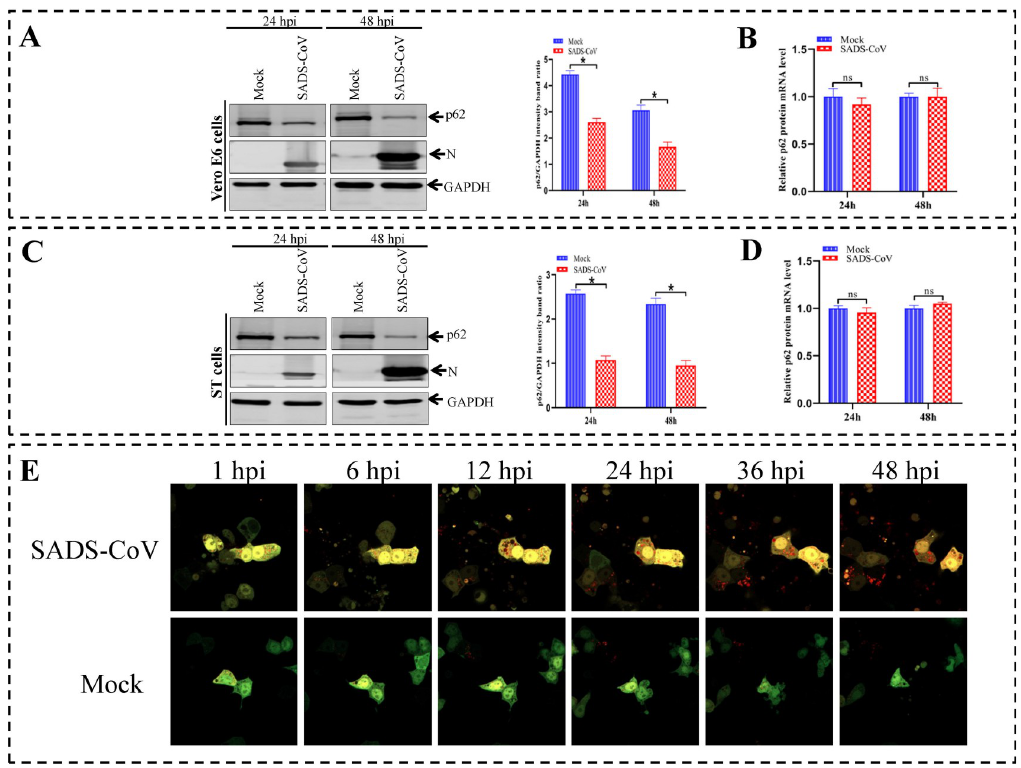
Fig 4. SADS-CoV-induced complete autophagy. ( A and C ) Vero E6 and ST cells are mock-infected or infected with SADS- CoV at the indicated time points (24 and 48 hpi), the cellular lysates are subjected to a western blotting analysis with anti-viral N and anti-p62 antibodies. GAPDH is used as a protein loading control. (B and D) Vero E6 and ST cells are pretreated and infected as described in A and C. Real-time RT-PCR was performed to measure p62 mRNA levels. ( E ) Vero E6 cells are transfected with plasmid GFP-RFP-LC3 for 12 h, and cells were infected or mock-infected with SADS-CoV at an MOI of 1. After absorption for 1 h, cells were observed over time by live cell imaging with RFP and GFP channels. Serial pictures obtained from the video at the indicated time points are shown. Means and SD (error bars) of three independent experiments are indicated ( � P < 0.05).